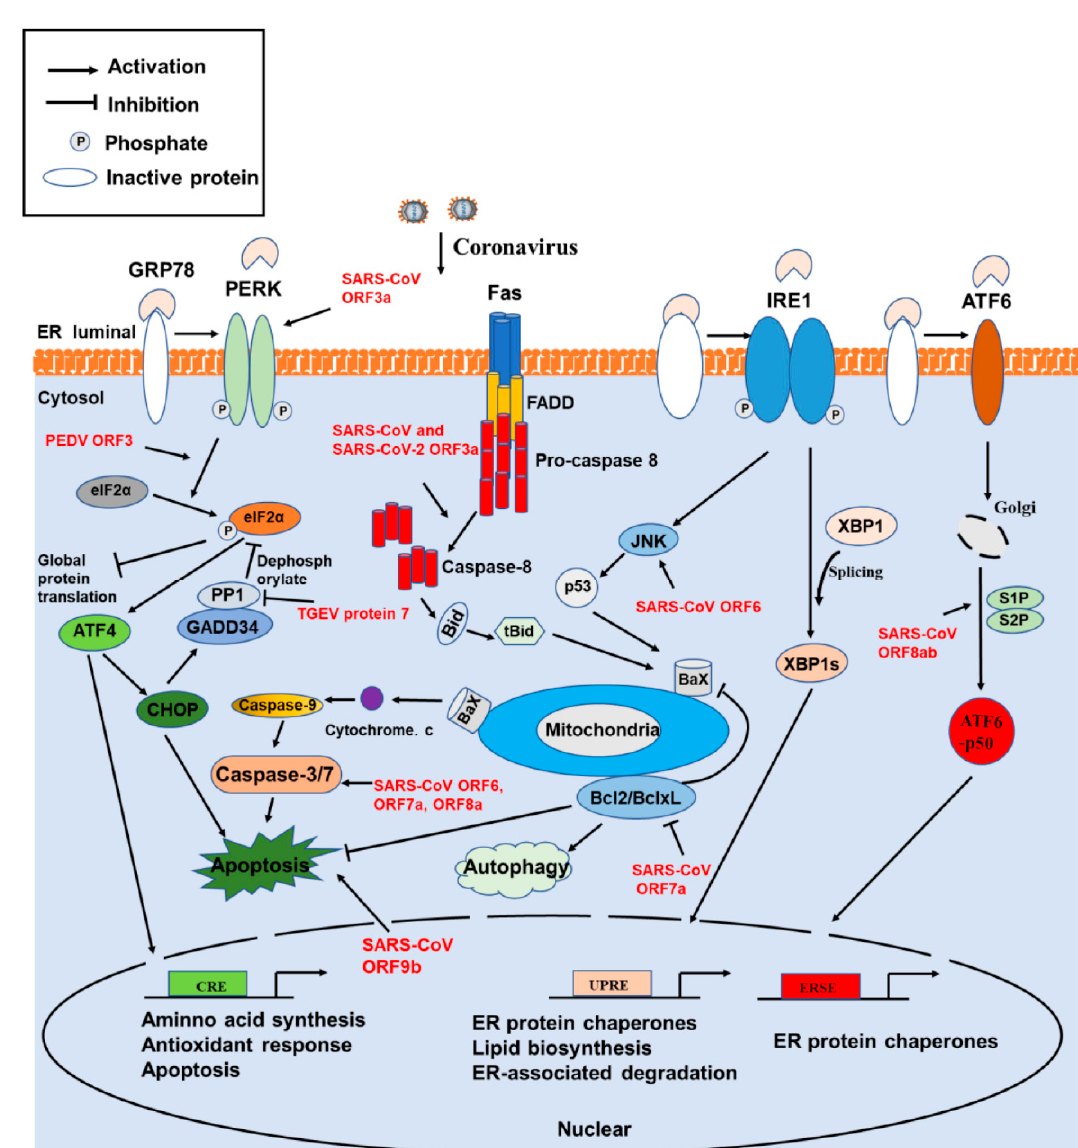
Figure 4. Modulation of unfolded protein responses, apoptosis, and autophagy by coronavirus accessory proteins. Schematic diagram showing the three arms of UPR signaling pathways and the correlated apoptosis and autophagy pathways regulated by accessory proteins. Accessory proteins modulating the pathway are shown in red. Abbreviations: PERK, PKR-like ER protein kinase; IRE1, inositol-requiring enzyme 1; ATF6, activating transcription factor 6; GRP78, glucose-regulated protein, 78 kDa; eIF2 α , eukaryotic initiation factor 2 subunit α ; ATF4, activating transcription factor 4; CRE, cAMP response element; CHOP, C/EBP-homologous protein; PP1, protein phosphatase 1; GADD34, growth arrest and DNA damage inducible 34; UPRE, unfolded protein response element; ERSE, ER stress response element; XBP, X-box-binding protein; JNK, c-Jun N-terminal kinases; Bcl-2, B-cell lymphoma 2/XL; Bcl-xL, Bcl-2-like protein 1; S1/2P, site-1/2 protease; FADD, Fas associated via death domain; BaX, Bcl2-associated X; Bid, BH3-interacting domain.